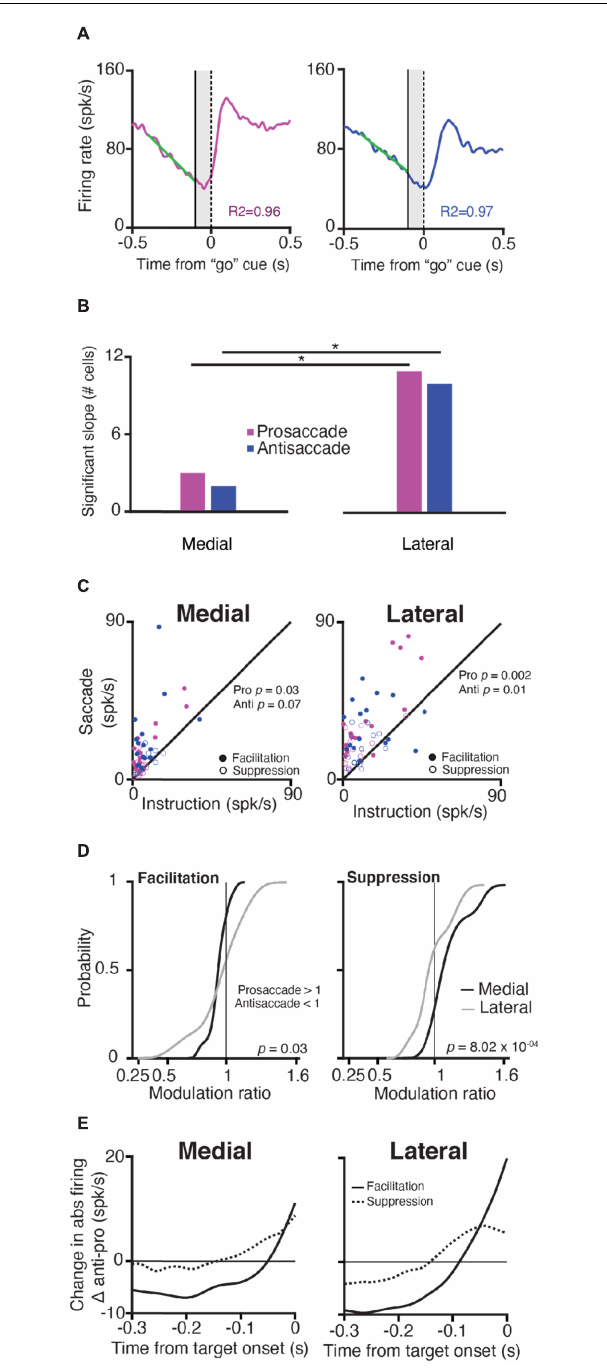
FIGURE 3 | Purkinje cells in the lateral cerebellum exhibit stronger modulation than PCs in the medial cerebellum during the instruction period. (A) Explanation of slope calculations used for panel (B) ; left , Time-course of SS responses during prosaccades (magenta) and antisaccades (blue); for example, a neuron in the lateral cerebellum aligned to the “go” cue (vertical dashed line at zero); right, the activity of the same neuron, but now for an antisaccade trial aligned to the “go” cue. A solid vertical line shows the end of the instruction period, the shaded area denotes the appearance of the target